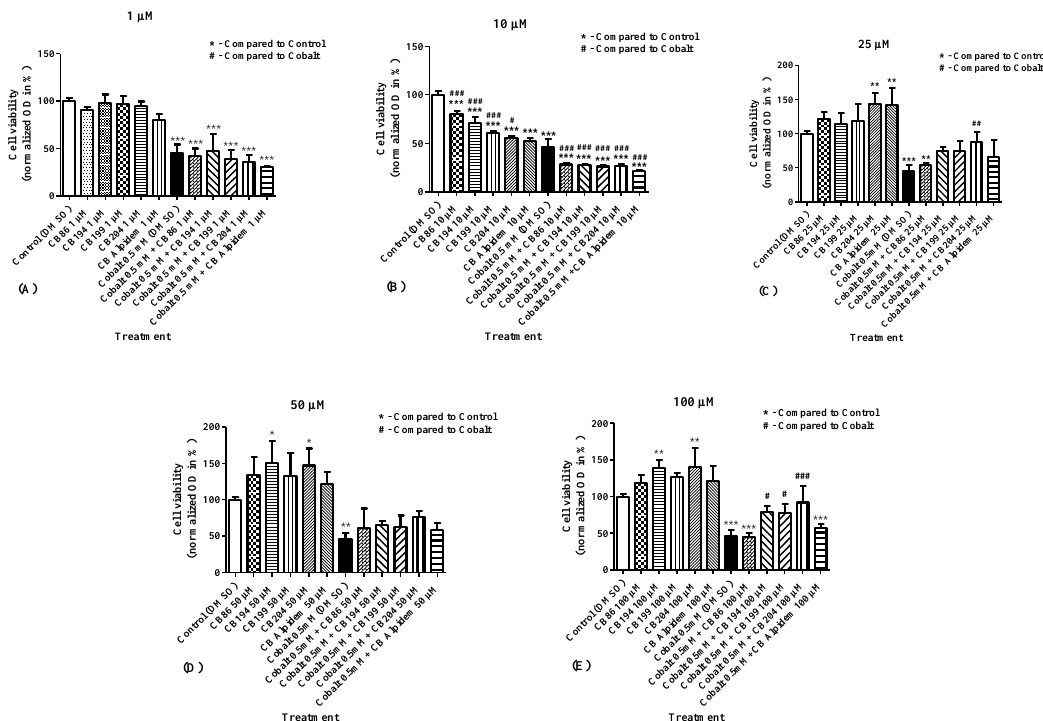
Figure 1. Determination of the ligand efficacy in inhibition of CoCl 2 -induced decrease in cellular viability (XTT assay). Cell viability was assessed following pretreatment with TSPO ligands at various concentrations of 1 µM, 10 µM, 25 µM, 50 µM, and 100 µM ( A–E ). Results are expressed as mean ± SEM ( n = 5 replicates in each group). # and * p < 0.05, ## and ** p < 0.01, ### and *** p < 0.001 .